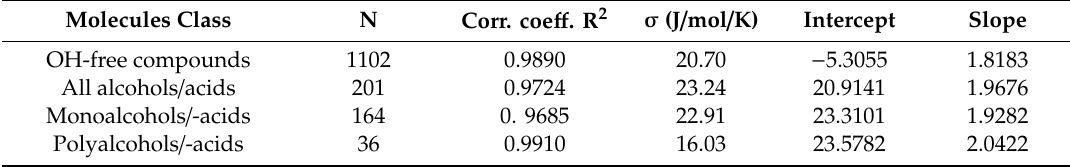
Table 8. Statistics of the correlations between molecular volumes and liquid heat capacities at 298.15K. Molecules Class N Corr. coe ff . R